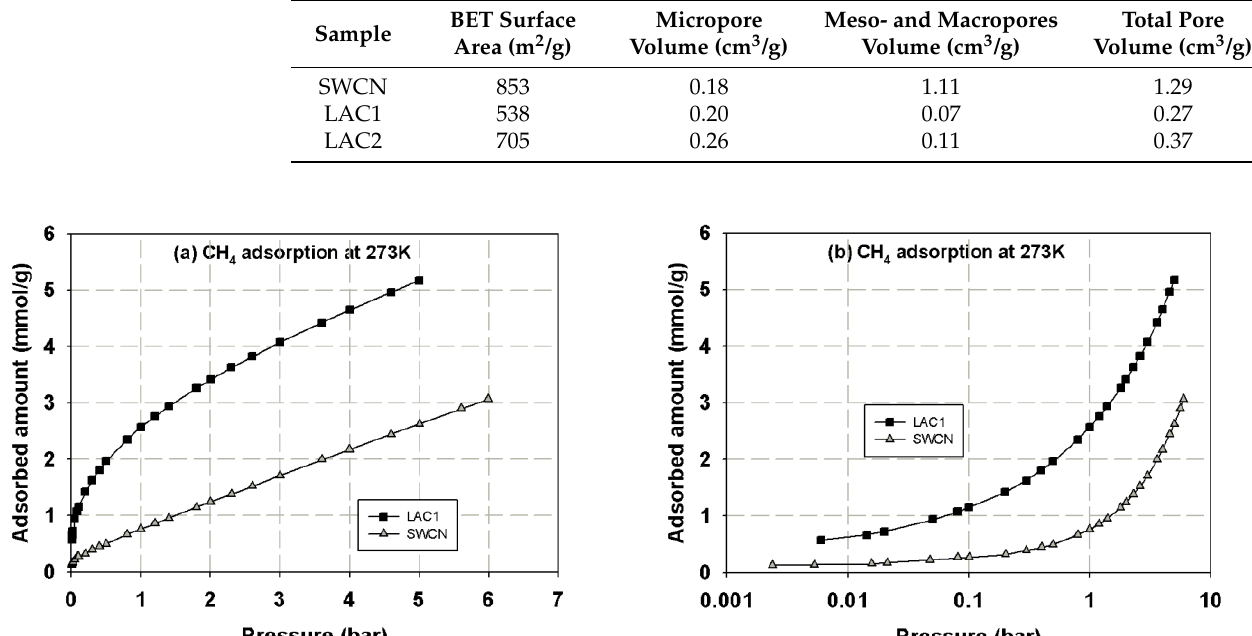
Figure 3. Adsorption isotherms of methane in activated carbons and single wall carbon nanotube at 273 K in linear ( a ) and semi-log ( b ) scales.